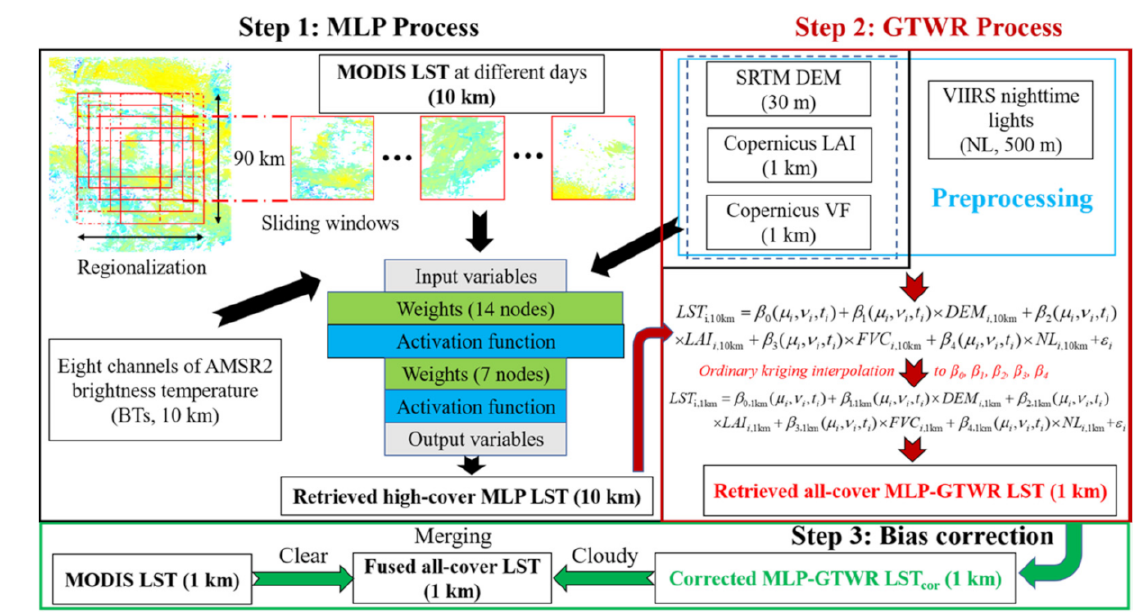
Figure 2. Schematic illustration of the multilayer perceptron-geographically and temporally weighted regression (MLP- GTWR)